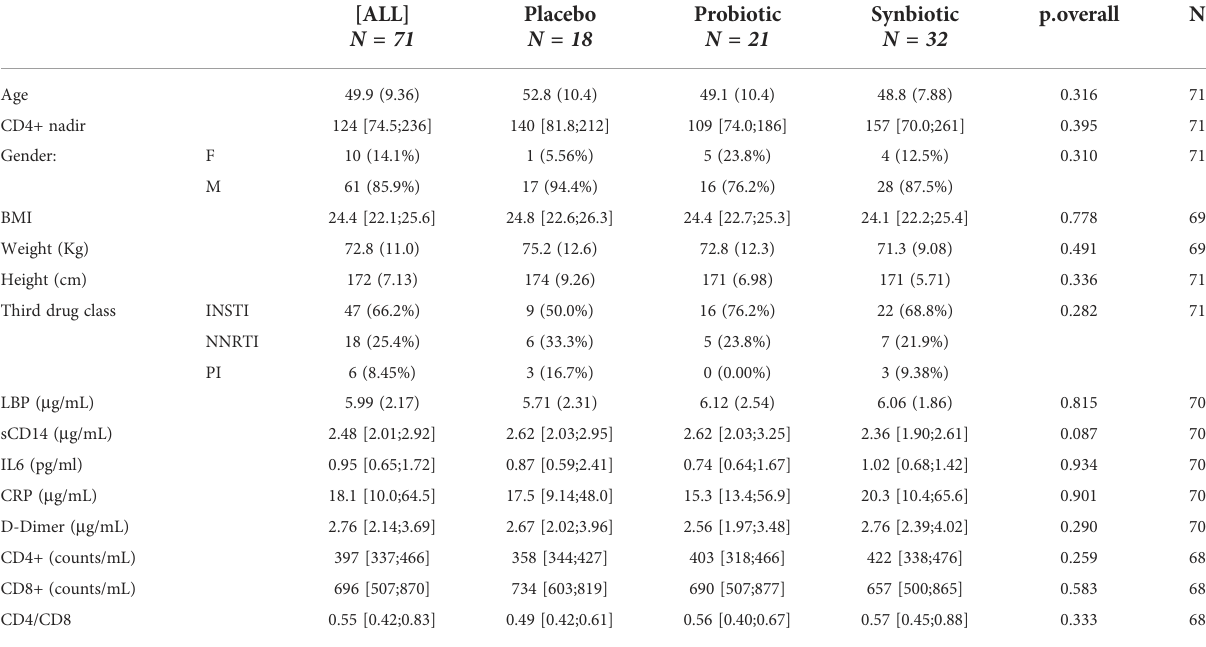
TABLE 1 Study population description of demographic variables and clinical markers at baseline: Age, height, LBP, and weight represented as mean-(sd), as they followed a continuous normal distribution (Shapiro test pval <